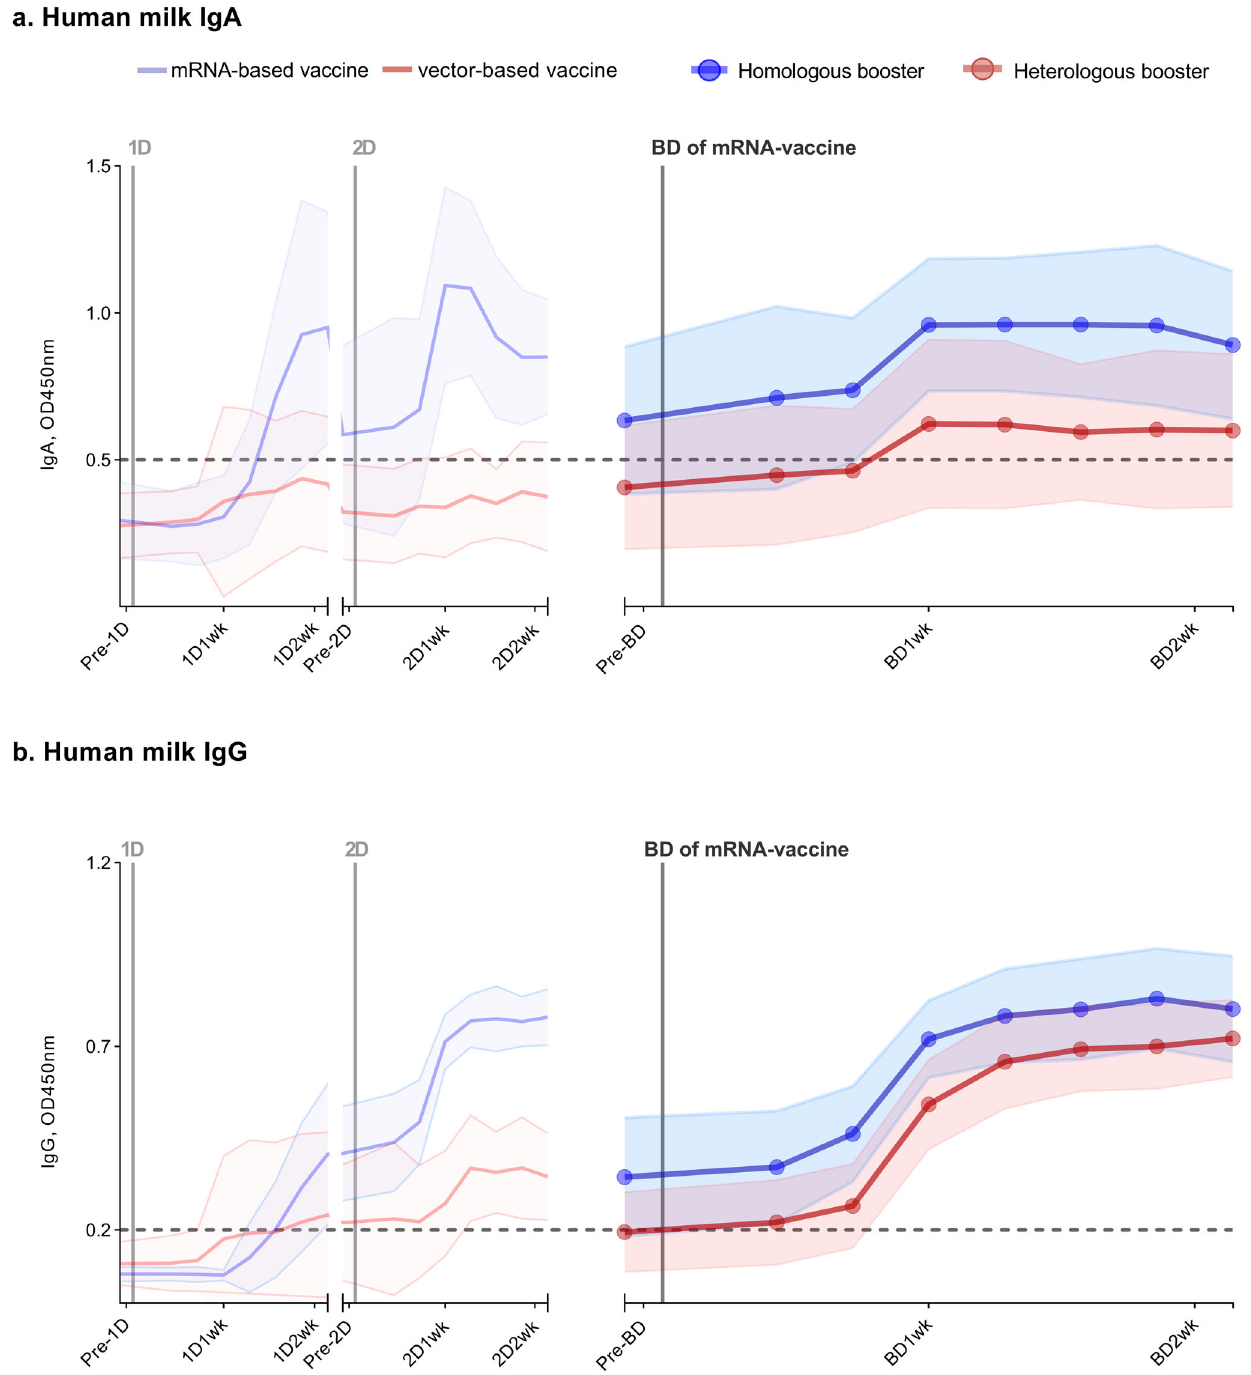
Fig. 3 COVID-19 vaccine-induced antibody response in human milk. Antibody response in human milk of 26 lactating women vaccinated against COVID- 19. SARS-CoV-2-speci fi c immunoglobulin A ( a ) and immunoglobulin G ( b ) in human milk were measured using an ELISA with the SARS-CoV-2 spike protein. Participants either received a primary series with an mRNA vaccine (2 × mRNA-1273 or 2 × BNT162b2), subsequently following a homologous boosting schedule ( n = 13), or a vector-based vaccine (2 × AZD1222 or 1 × Ad26.COV2.S) and thus following a heterologous boosting schedule ( n = 13). The left part of both graphs (from pre-1D to 2D2wk), is already described in our previous study 10 . The time between the fi rst dose and booster dose in the homologous group was, on average, 338 days (BNT162b2) and 262 days (mRNA-1273), and in the heterologous group, 234 days (Ad26.COV2.S) and 285 days (AZD1222). Analyzed samples were collected prior to a vaccine dose, 3 days, 5 days, 7 days, 9 days, 11 days, 13 days, and 15 days after a vaccine dose. 1D, fi rst vaccine dose; 2D, second vaccine dose; BD, mRNA-vaccine booster vaccine; Pre, one day prior to; 1wk, one week after; 2wk, two weeks after vaccine dose. Data points represent the mean of all measurements per group; the shaded area around the mean represents the standard deviation. Cutoff values are indicated with dashed lines. OD450nm, optical density 450 nm. Source data are provided in the Supplementary Data 1 fi